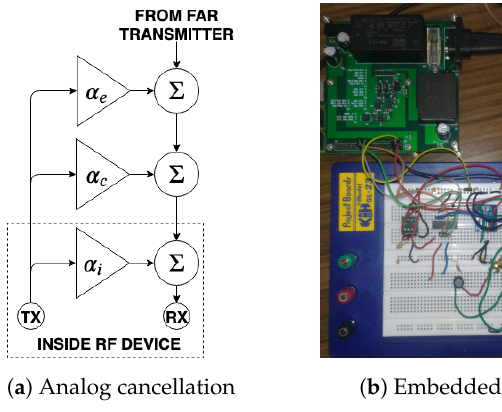
Figure 2. Embedded system for controlling parallel cancellation